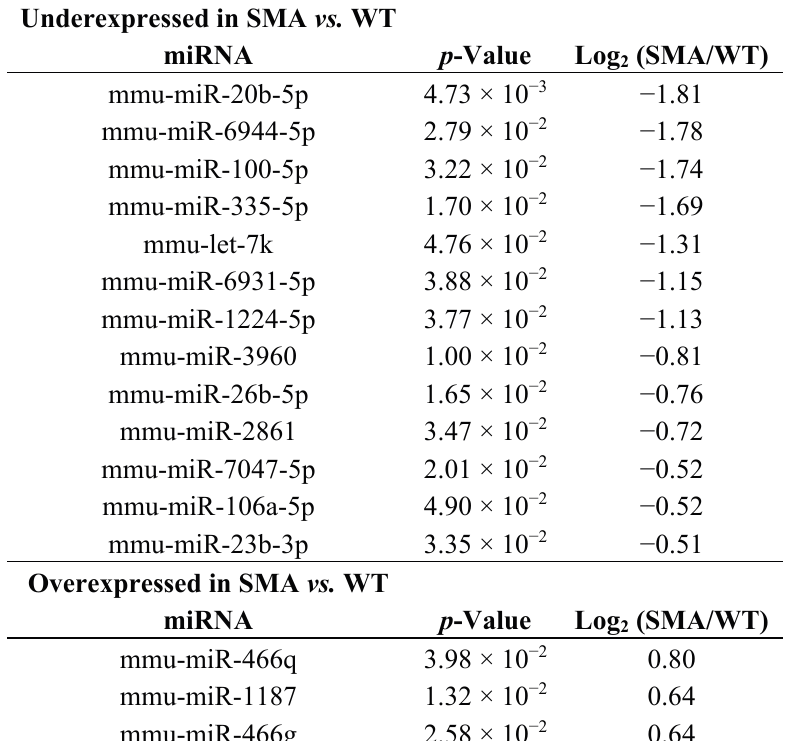
Table 1. MicroRNAs differentially expressed in SMA vs. WT NSCs. Underexpressed in SMA vs.